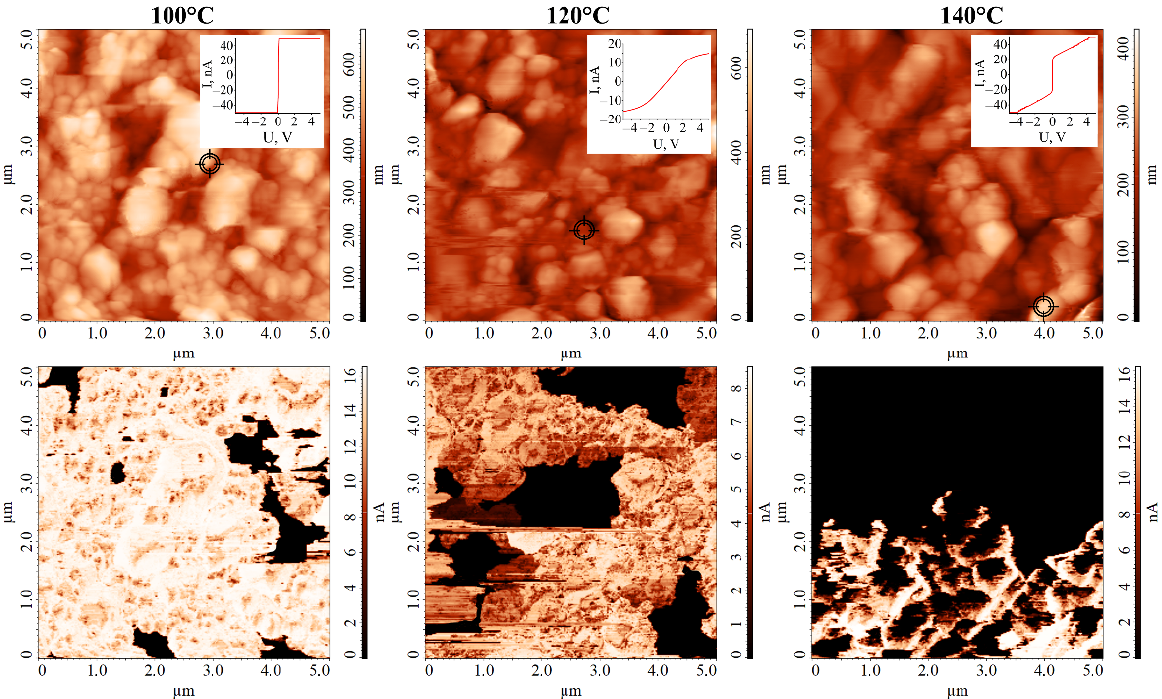
Figure 7. AFM microphotographs of Ag films grown at different temperatures ( top —surface relief of the films; bottom —the corresponding current distribution maps; inset —current–voltage curves obtained at the specified points).